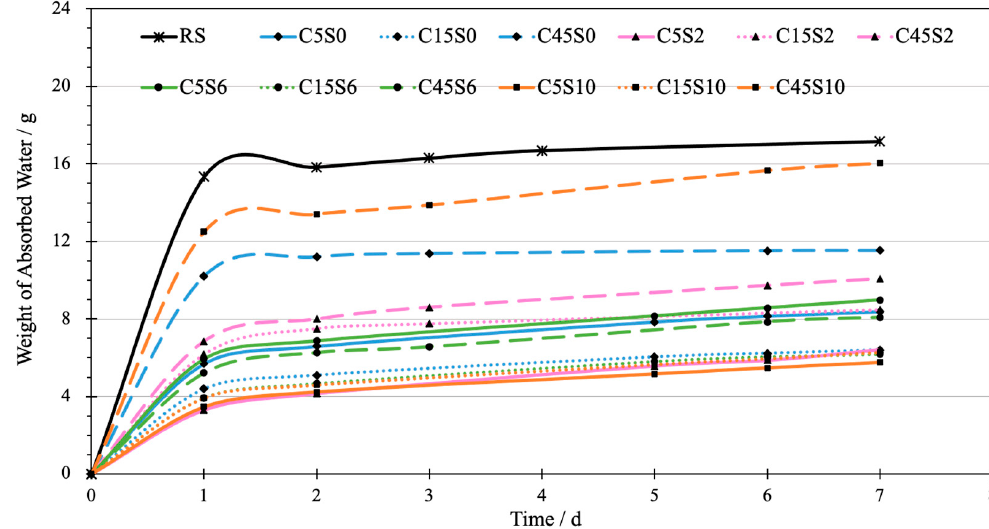
Figure 11. Evolution of absorbed water weight with the change of time.